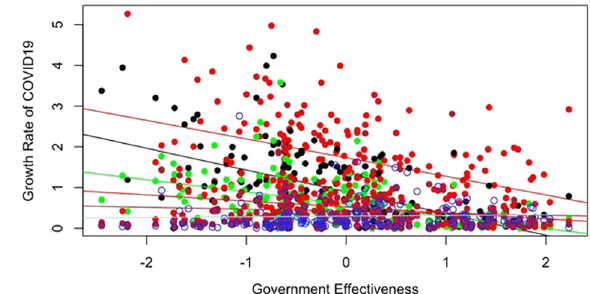
Fig. 4 The relationship between government effectiveness and the COVID- 19 positive rate.